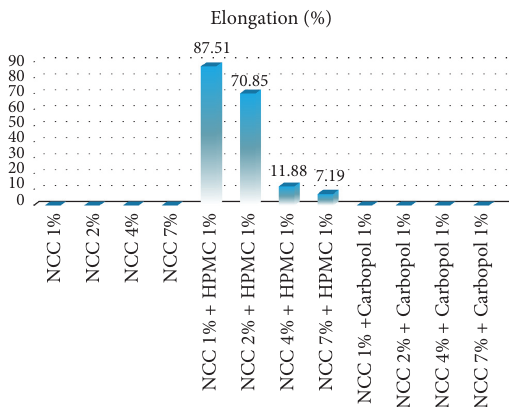
Figure 6: The elongation (%) values for 1%, 2%, 4%, and 7% NCC with hydroxypropyl methylcellulose (HPMC) and carbopol.